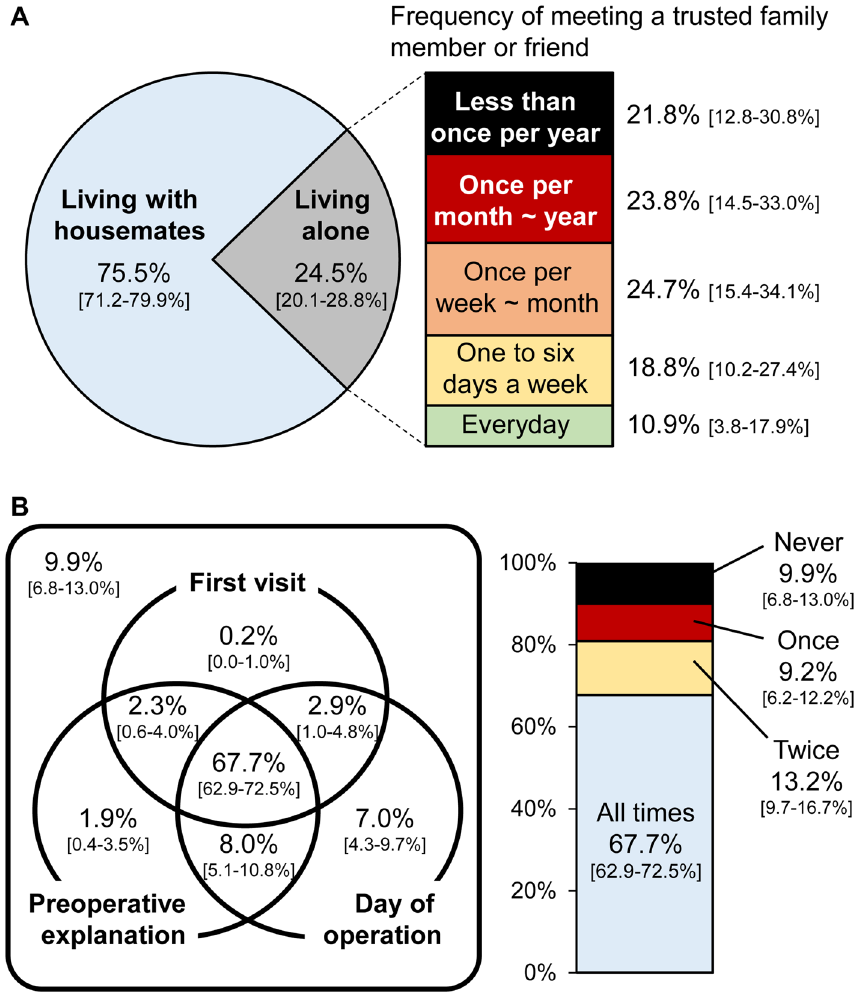
Figure 1. Social isolation of the study population ( n = 413). ( A ) Shows the residence status of the study population (the pie chart on the left) and the frequency of patients living alone meeting a trusted family member or friend (the band graph on the right). ( B ) Shows the frequency of hospital visitation of patients living alone by a trusted family member or friends on three key occasions: (1) the patient’s first visit to the vascular